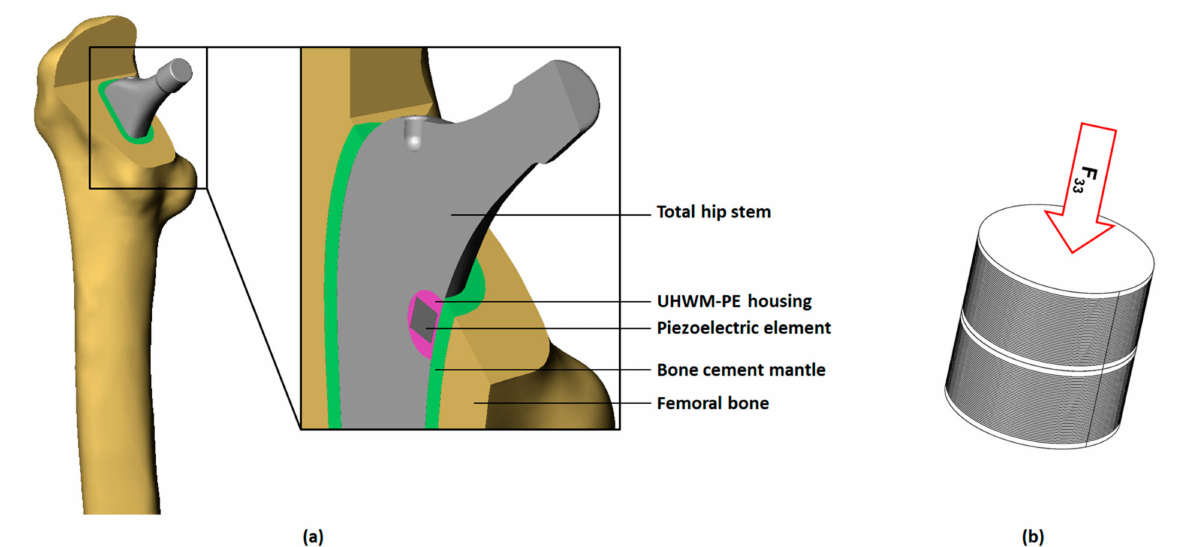
Figure 1. ( a ) Femoral bone segment with modified hip stem implanted; in the detail view (cross section) the components of the EHS are visible including a cylindrical piezoelectric element. ( b ) Loading of an arbitrary cylindrical piezoelectric element with the force F 33 transmitted through the implant and the UHMW-PE housing. The piezoelectric element in this picture is formed by stacking two single multilayer elements with passive top and bottom layers.